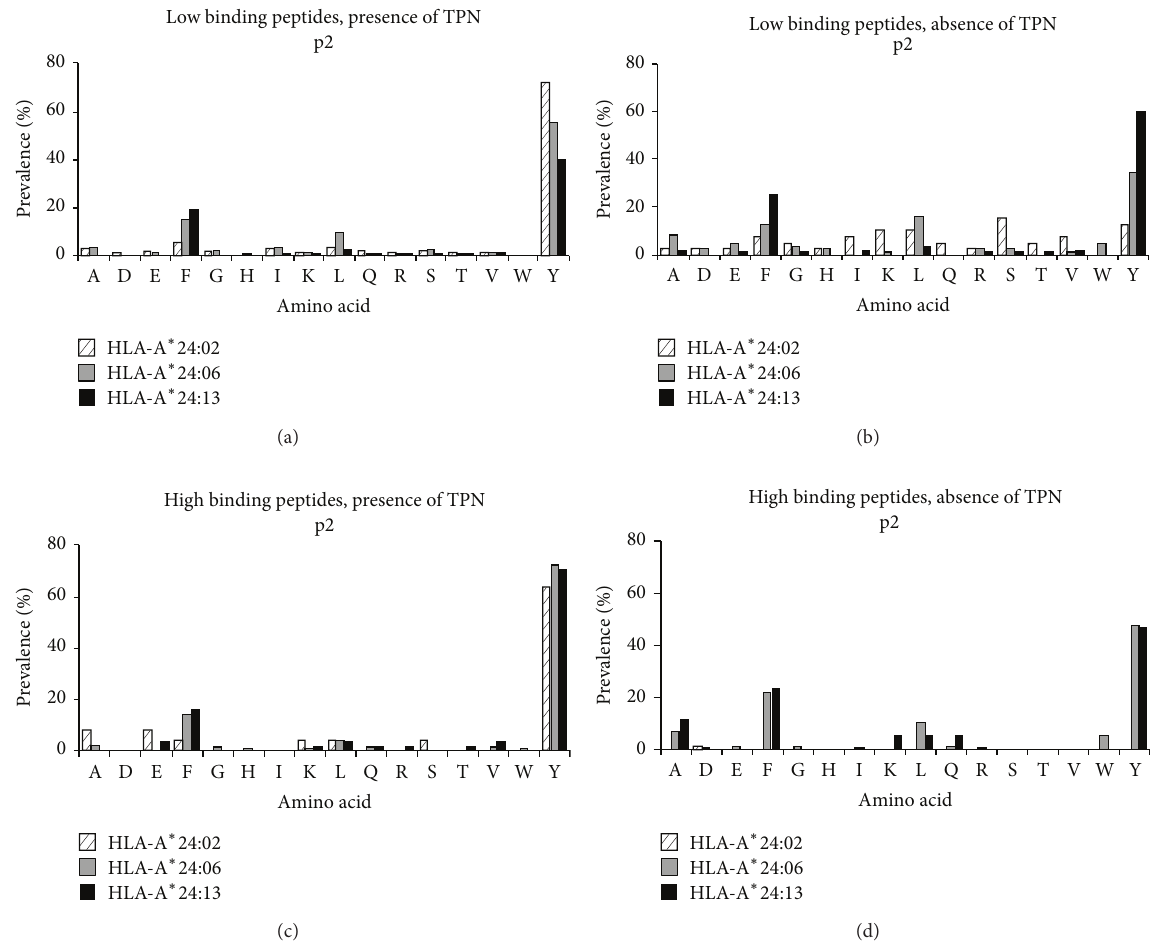
Figure 6: Frequency of amino acids occurring at p2 in peptides eluted from HLA-A ∗ 24/156 variants. 𝑥 -axis represents AA residues at p2 occurring in sHLA-A ∗ 24:02 (crossed), sHLA-A ∗ 24:06 (grey bar), and sHLA-A ∗ 24:13 (black bar). 𝑦 -axis represents percentage prevalence of individual residue at